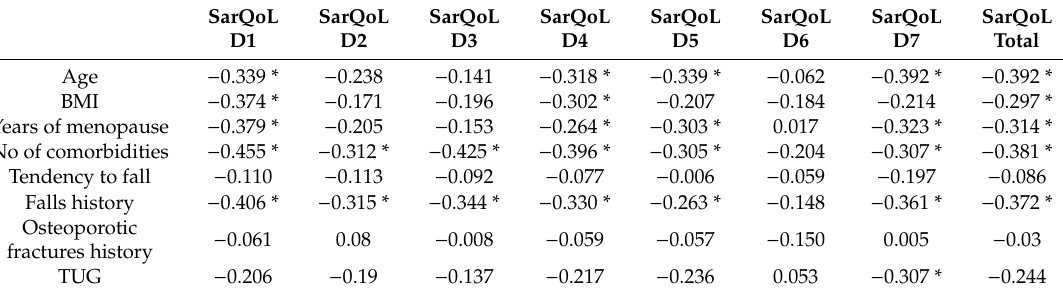
Table 3. Correlations between Sarqol Domaines and Clinical Variables.